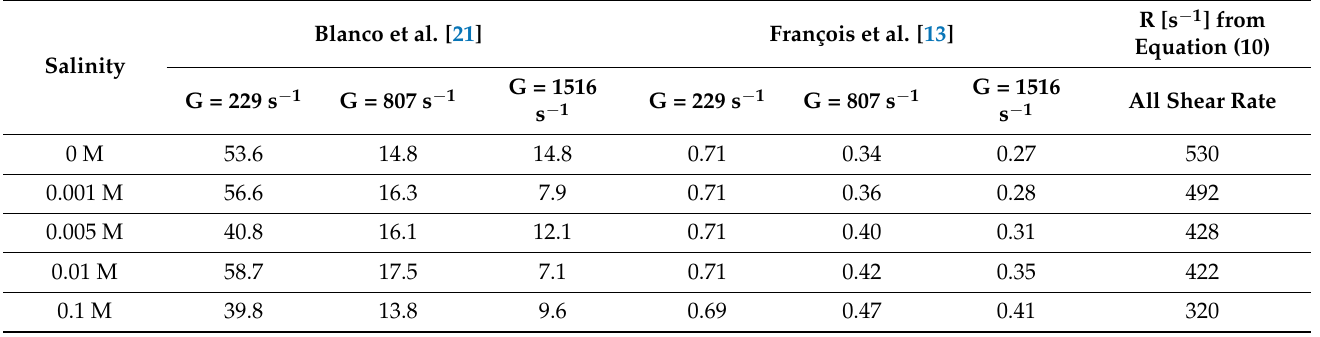
Table 5. Effect of salinity and shearing on the resistance of flocculated kaolin aggregates in a saline medium. Resistance is obtained through different methodologies.